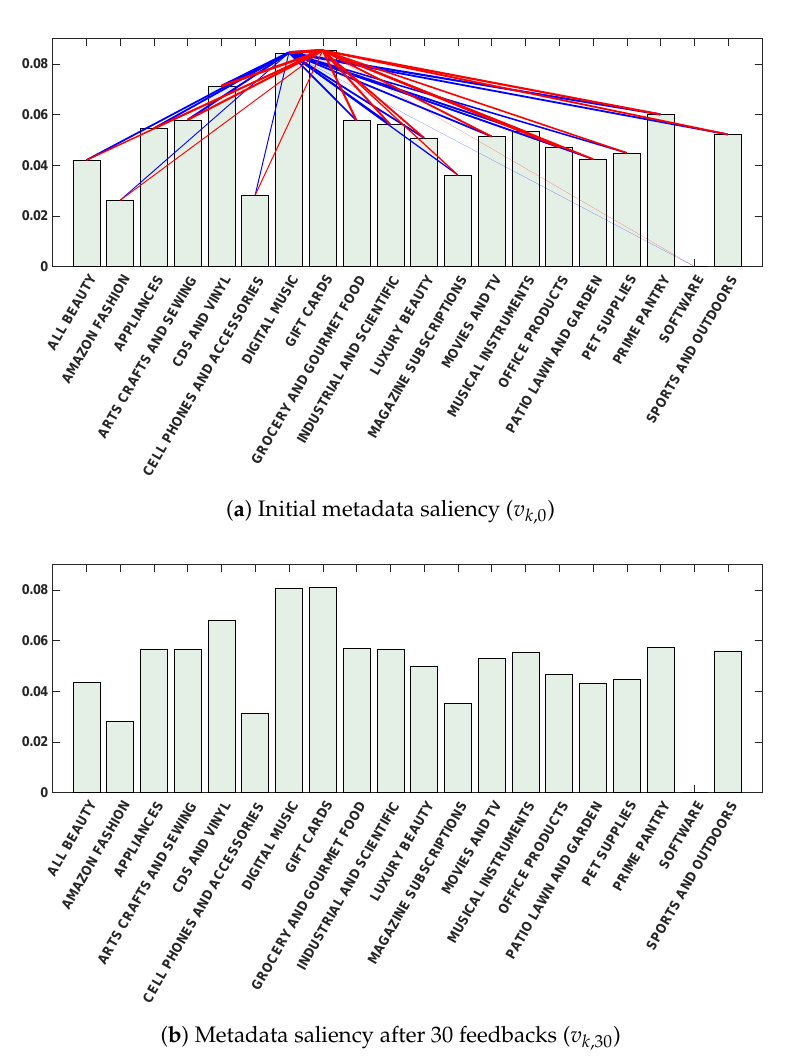
Figure 9. The effect of implicit feedback on metadata saliency (Amazon